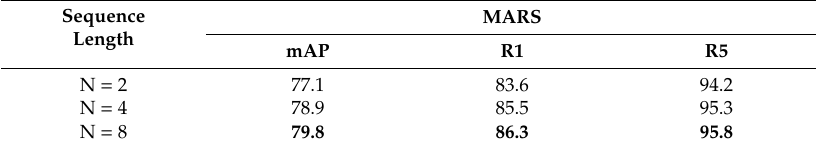
Table 6. Evaluation of the e ff ect of di ff erent sequence lengths N on the MARS dataset on our best fourth and fifth CNN blocks.